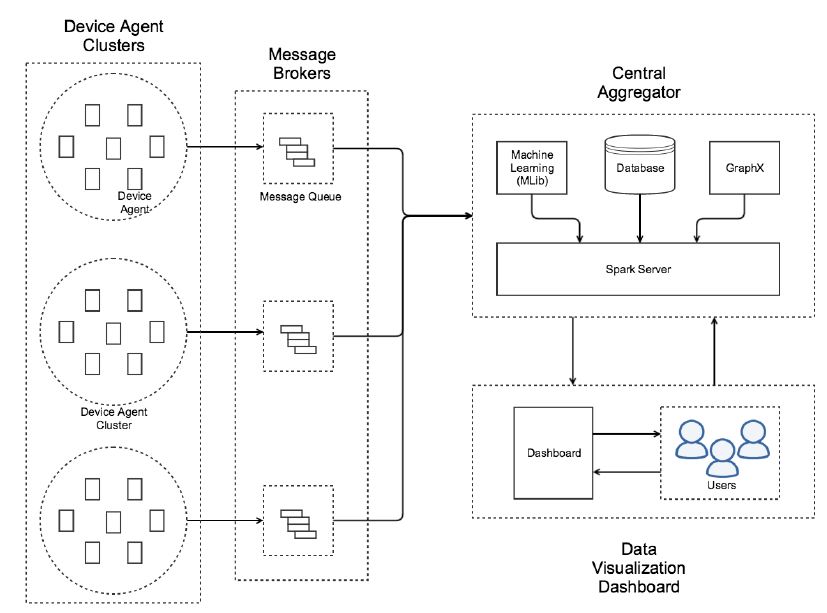
Figure 2. Overview of proposed IDS